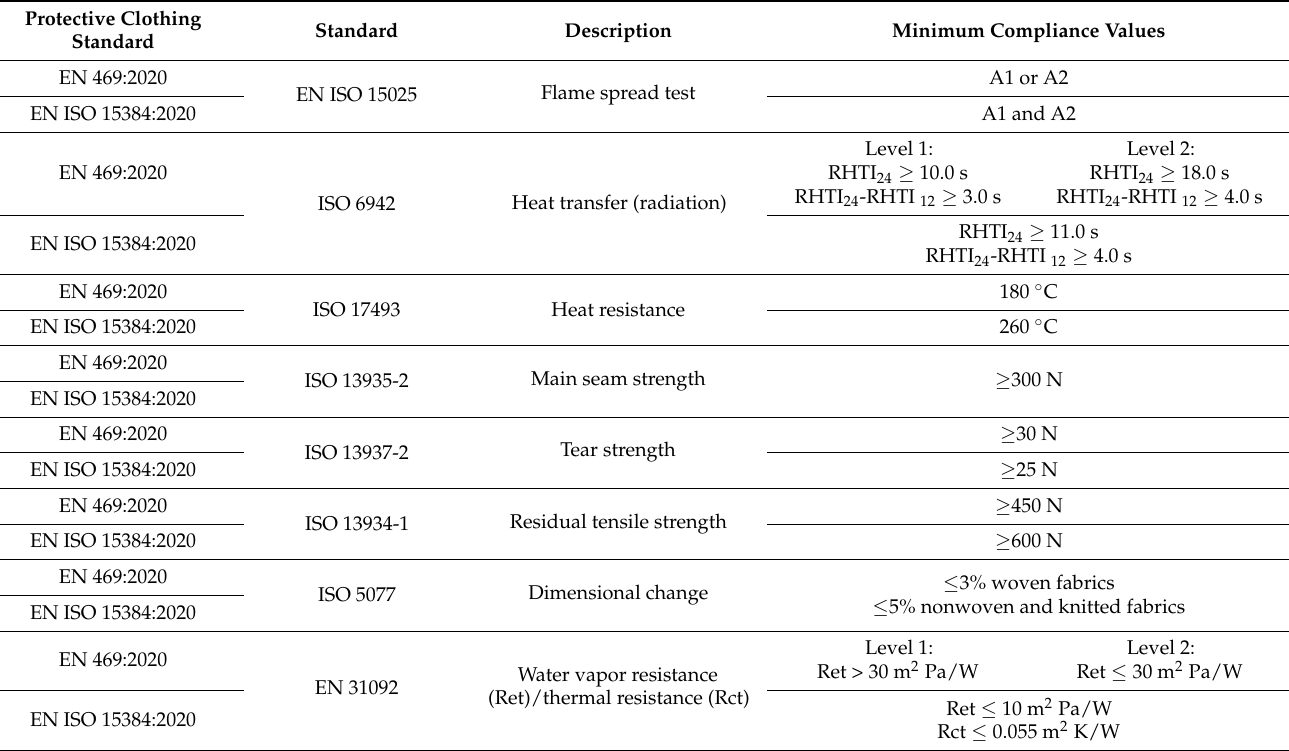
Table 1 comprises a comparison regarding the minimum compliance values for test meth- ods used both in structural and wildland firefighting protective clothing standards. Table 1. Comparison between the minimum compliance values for wildland and structural fire- fighting protective clothing, which used the same test methods.